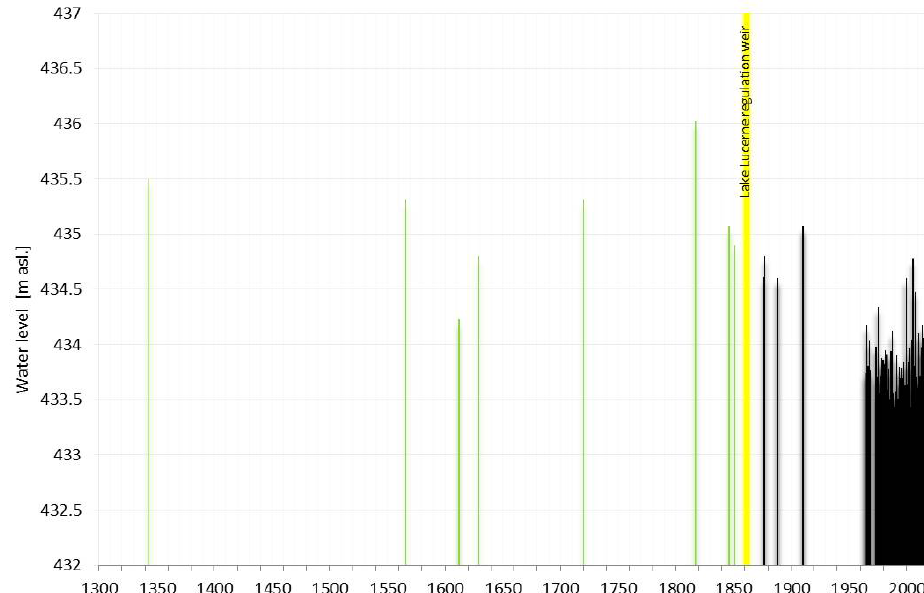
Figure 12. Long-term stationarity of Lake Lucerne and Reuss River extreme flood water levels (Wetter et al., 2015) or slow trends of decreasing flood magnitudes (?). Green bars: reconstructed flood levels above sea level (a.s.l.). Black bars: measured flood levels a.s.l. Yellow bar: significant anthropogenic intervention in the discharge